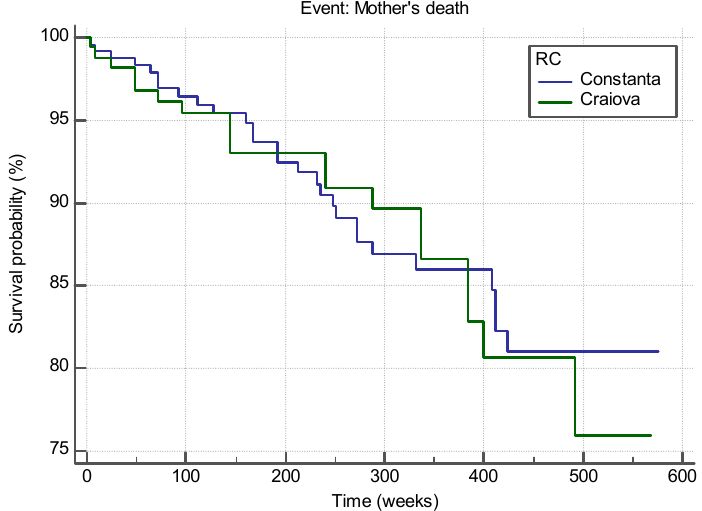
Figure 1. Survival curves of HIV-positive pregnant women from the two RCs, Constanta and Craiova.